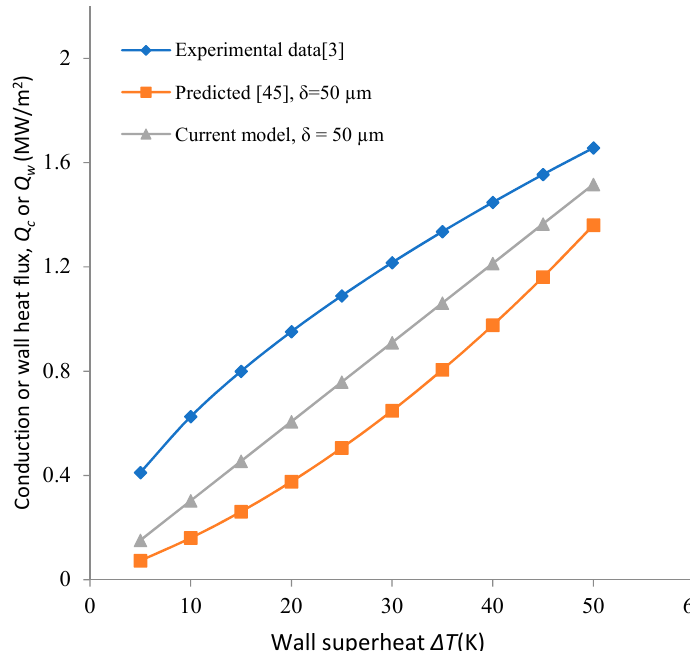
Figure 7. Comparison of predicted heat fluxes with experimental data at a function of wall superheat.